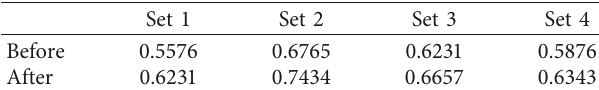
Table 4: Comparison of results of different data set before and after using optimization (data set